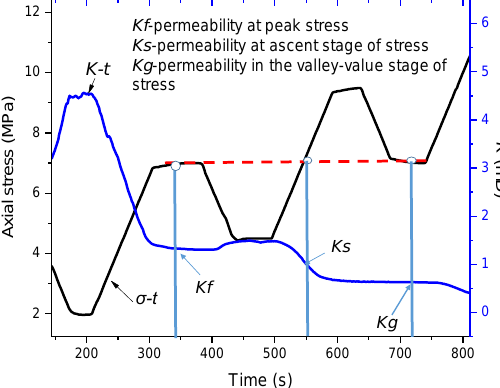
Figure 12. The definitions of permeability indices under stress path 1.